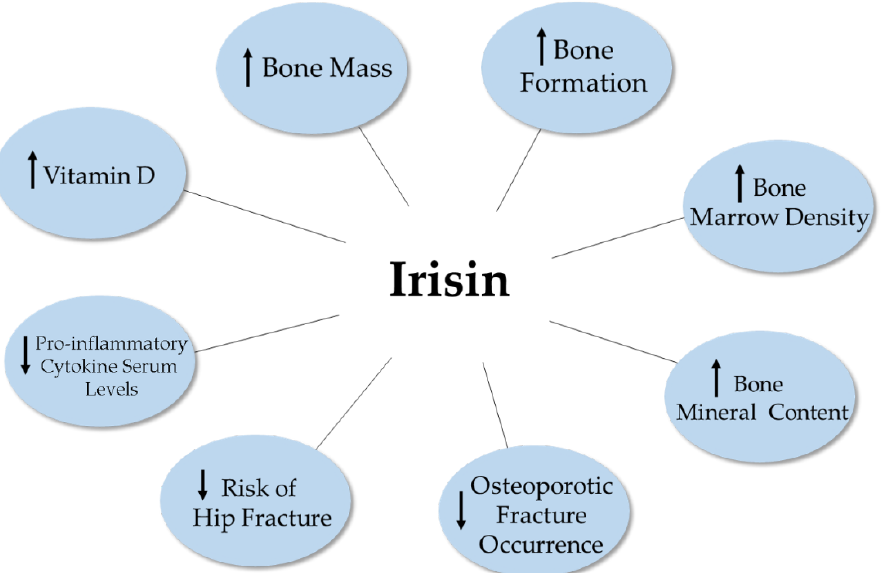
Figure 5. Clinical evidence of the role of irisin on bone homeostasis. Increased serum irisin levels have been associated with increased bone mass, reduced risk of fracture, decreased serum cytokine levels, and increased serum Vitamin D levels. The figure is based on the data of the studies [87,89,90,92 – 95,97], and created using BioRender. Available online: https://biorender.com (accessed on 3 February – 17August 2021).